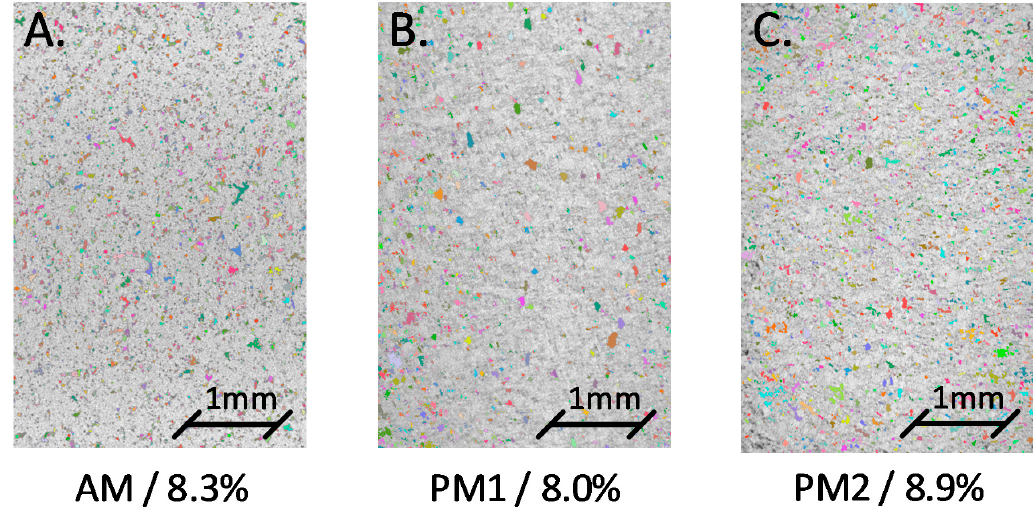
Figure 7. 2D images extracted from the CT scans: ( A ) AM (porosity 8.3%); ( B ) PM1 (porosity 8.0%) and ( C ) PM2 (porosity 8.9%); colors are added for better visualization only.